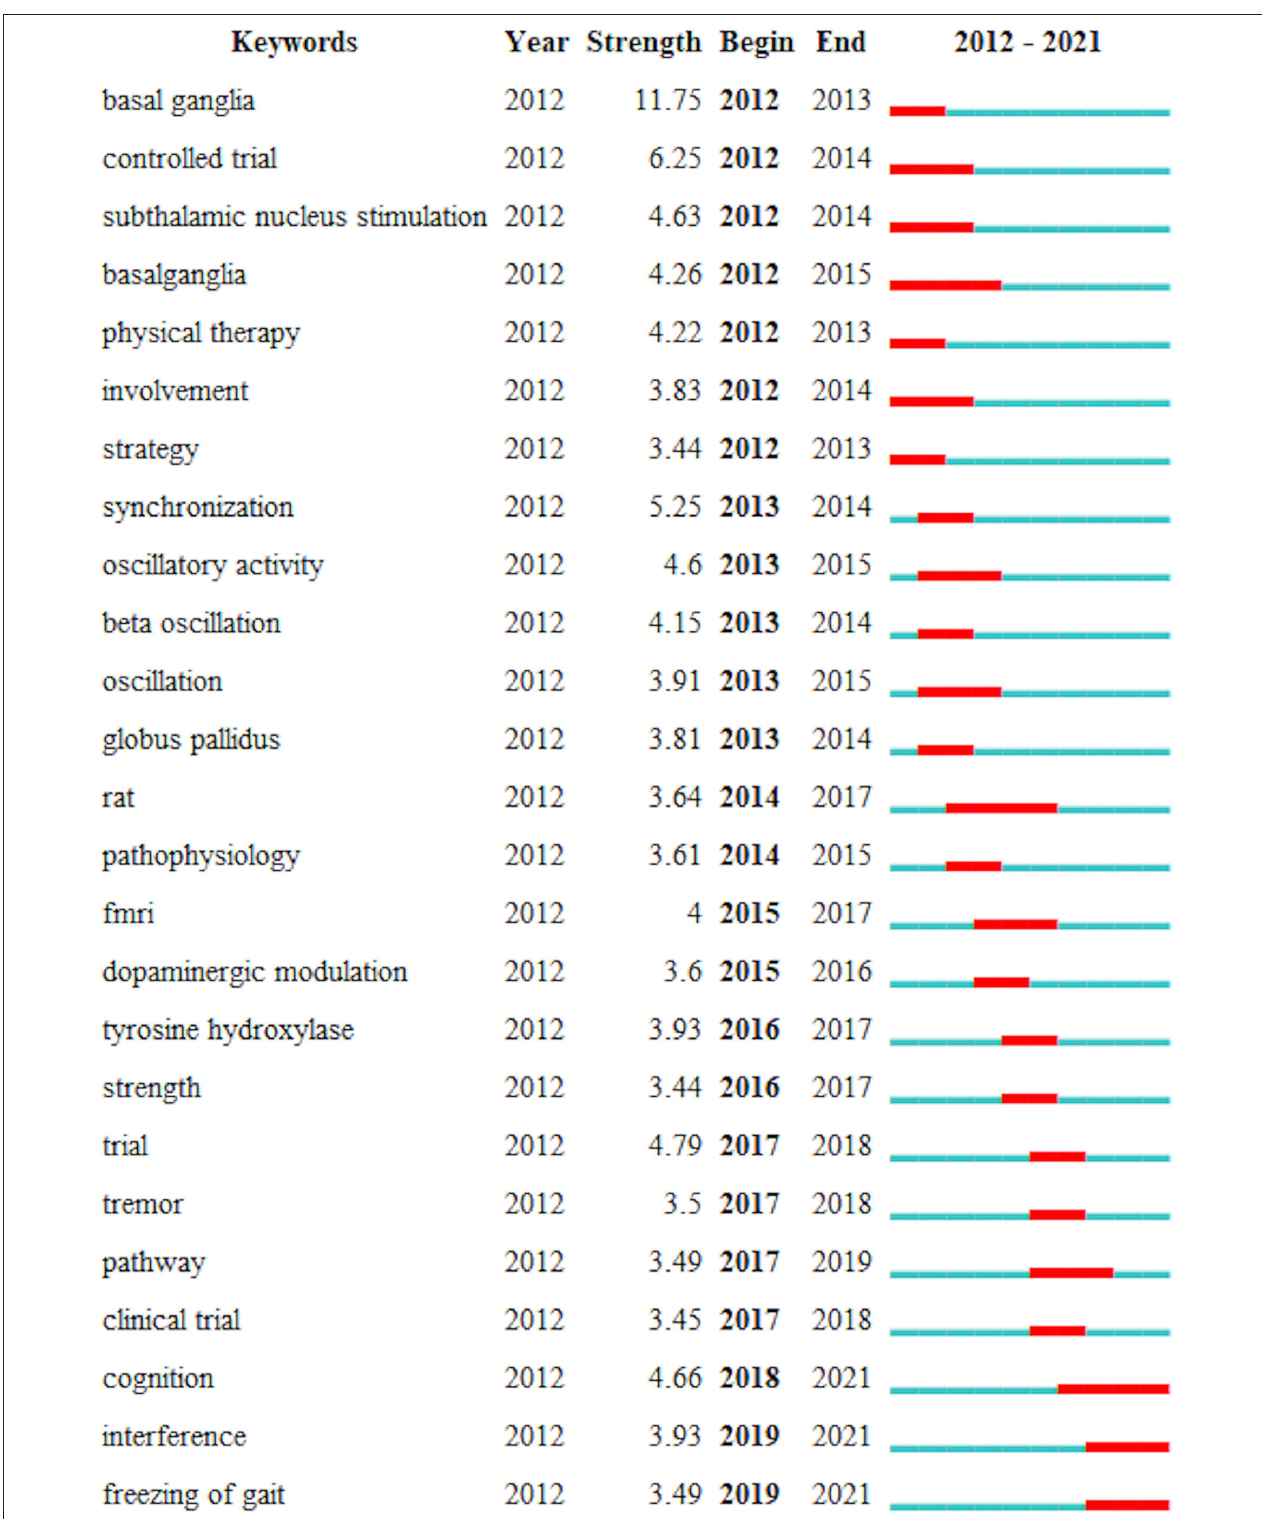
FIGURE 9 | Top 25 key words with the strongest citation bursts. Red bars: some key words cited frequently; blue bars: key words cited infrequently.